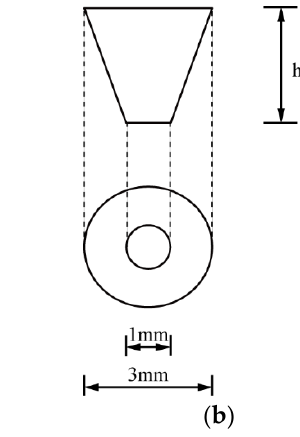
Figure 7. Artificial pitting corrosion: ( a ) samples of one group; ( b ) configuration.